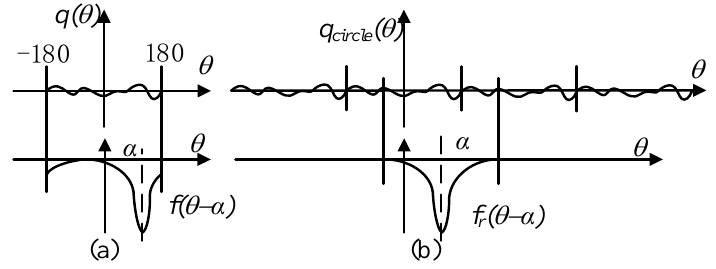
Figure 10. Explanation of Equations (15) ( a ), and Equations (16) ( b ).